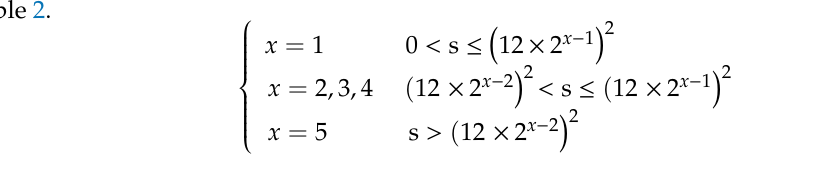
Table 1. Size attribute of objects in LAKE-BOAT.